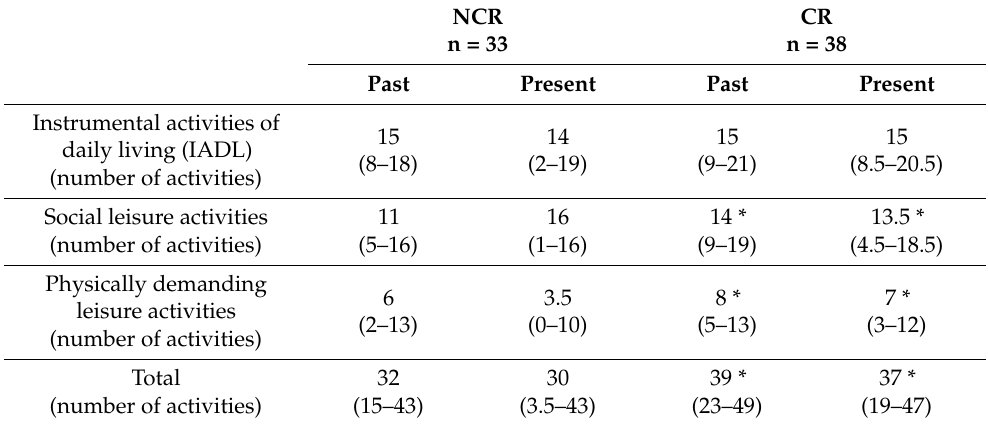
Table 2. Number of activities (median (min–max)) in participation domains before and after MI.